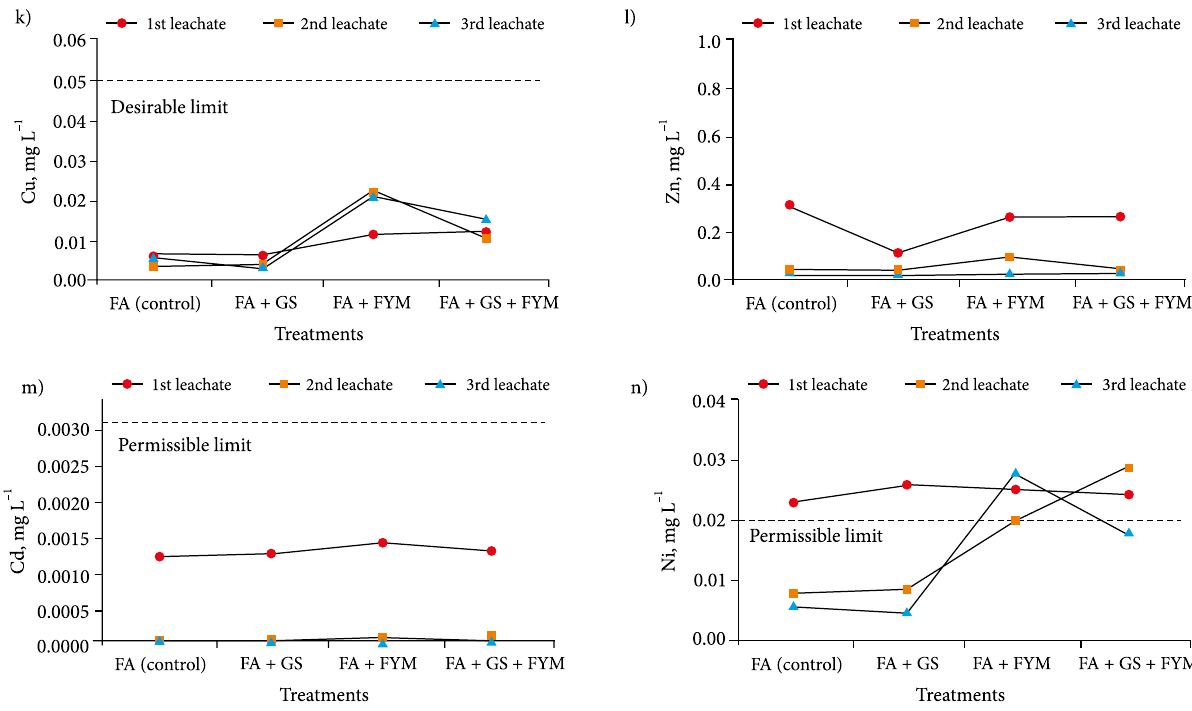
Fig. 6. Characteristics of pot leachates collected at 1 st (initial stage), 2nd stage (3rd month), and 3 rd stage (4 th month or harvest stage) during growth of Cymbopogon citratus on amended fly ash; pH (a) electrical conductivity (EC) (b); total hardness (TH) (c), total dissolved solid (TDS) (d) total alkalinity (e), calcium hardness (Ca H) (f), magnesium hardness (Mg H) (g), chloride (h); sulphate (i) Mn (manganese) (j), Cu (copper) (k), zinc (Zn) (l), cadmium (Cd) (m), nickel (Ni)